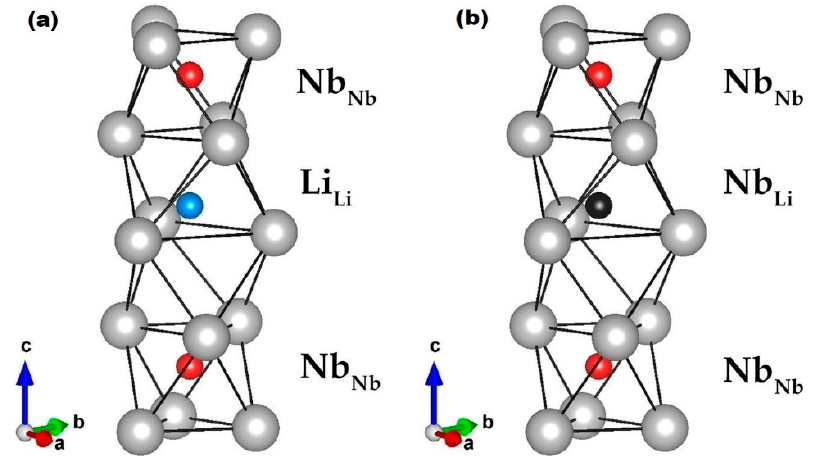
Figure 4. Comparison between the ideal and nonideal LiNbO 3 crystal structure. ( a ) Free from point defects describing the stoichiometric composition. ( b ) Under the most likely situation in which Nb antisites are present.